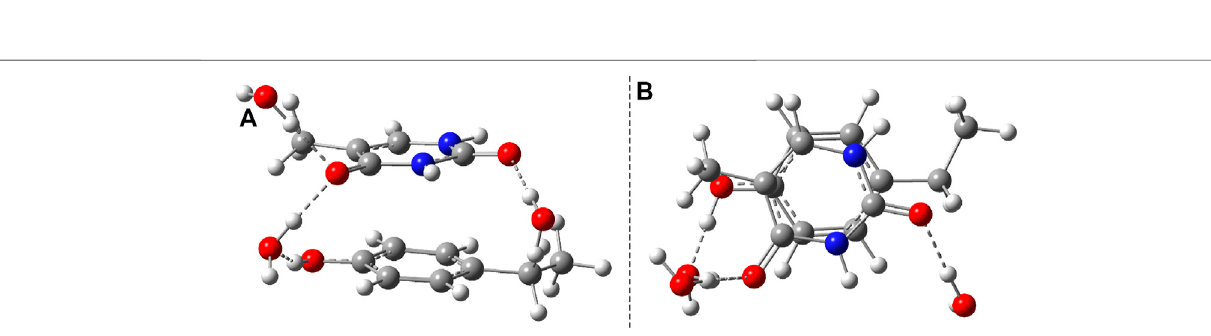
FIGURE 10 | The Natural Difference Orbitals (orange (cid:1) hole and blue (cid:1) electron) computed for the fi rst three low-lying excited states of the phenol – uracil (P – U) complex using the TD- ω B97X-D3/ma-def2-TZVPP level of theory.